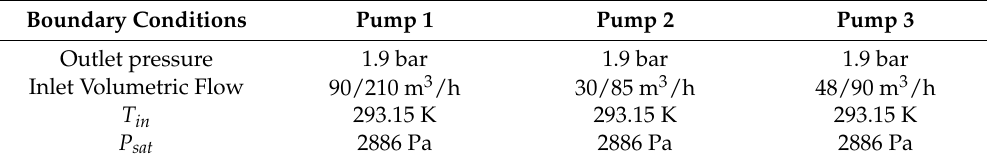
Table 2. Boundary